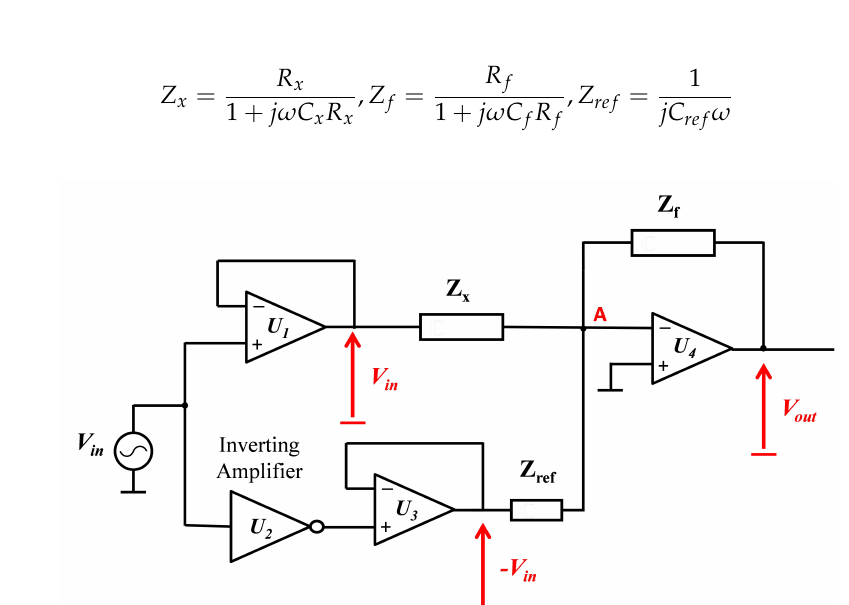
Figure 12. Current detector circuit including the impedance to be measured Z x and reference impedance Z ref